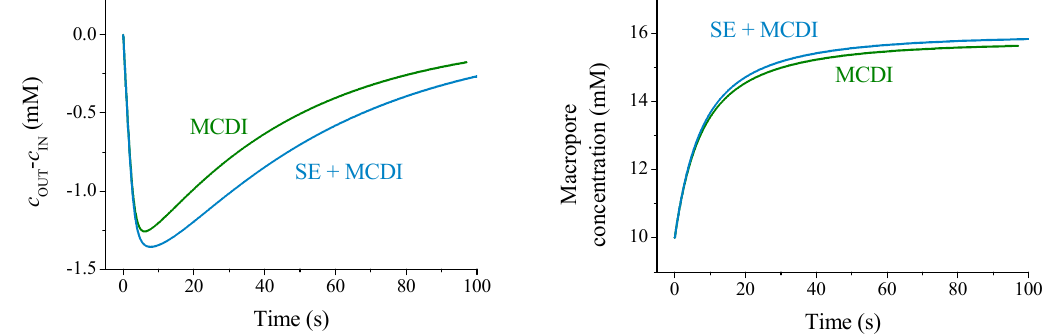
Figure 9. Theoretical predictions of concentration difference ( left ) and macropore concentrations ( right ) comparing MCDI and SE + MCDI. The quantities used for the calculation are: Porosities p µ = 0.2 ( micro ) , p M = 0.3 ( macro ) ; stern capacitance C St = 10 8 F/m 3 ; dimensions of, respectively, membrane, spacer and electrode: L mem = 140 µ m, L sp = 500 µ m, L e = 300 µ m; Charge densities of membrane and polyelectrolyte: 5 × 10 3 mol/m 3 , and 10 3 mol / m 3 .